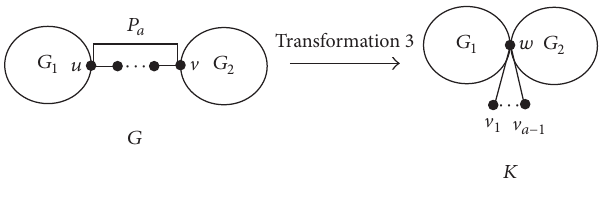
Figure 3: Transformation